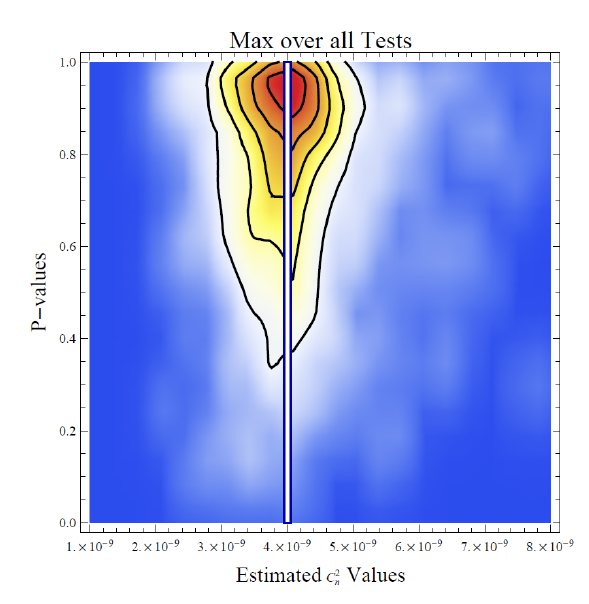
Fig. 12. Probability values as a function of C 2 η 1η estimates: maxi- mum over all tests.